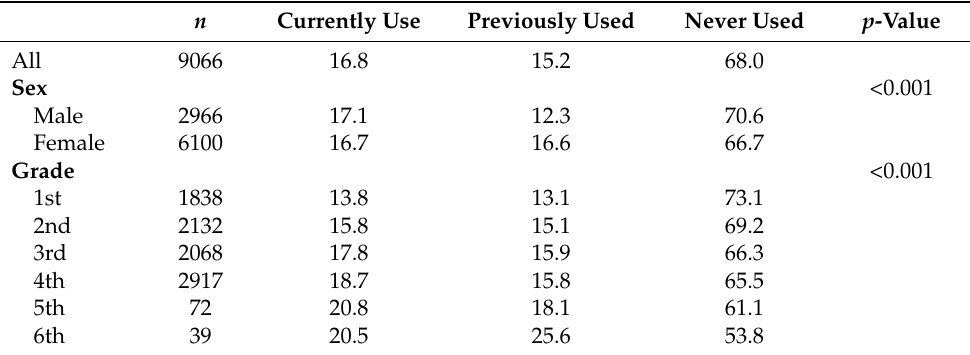
Table 2. Prevalence of dietary supplement